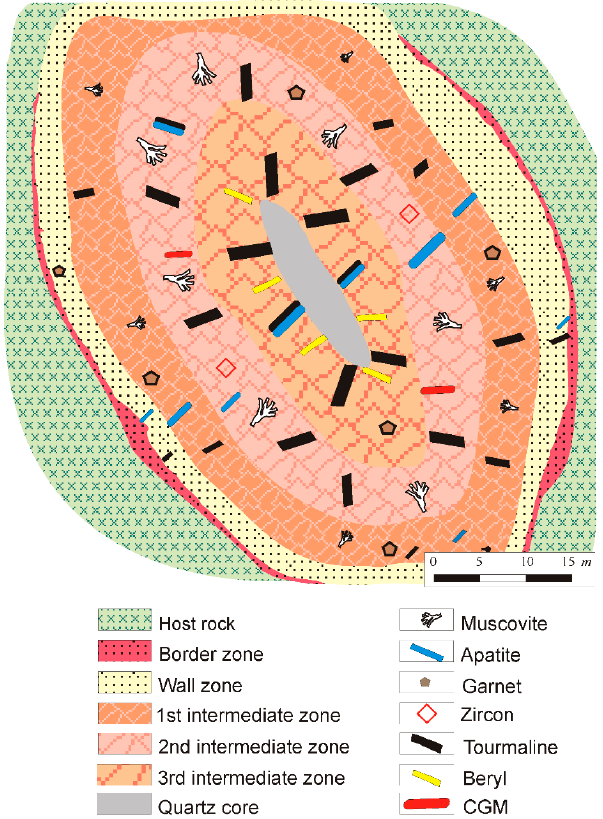
Figure 6. Conceptual scheme (not to scale) of the various pegmatite units in type-III pegmatites and distribution of the most significant minerals. distribution of the most significant